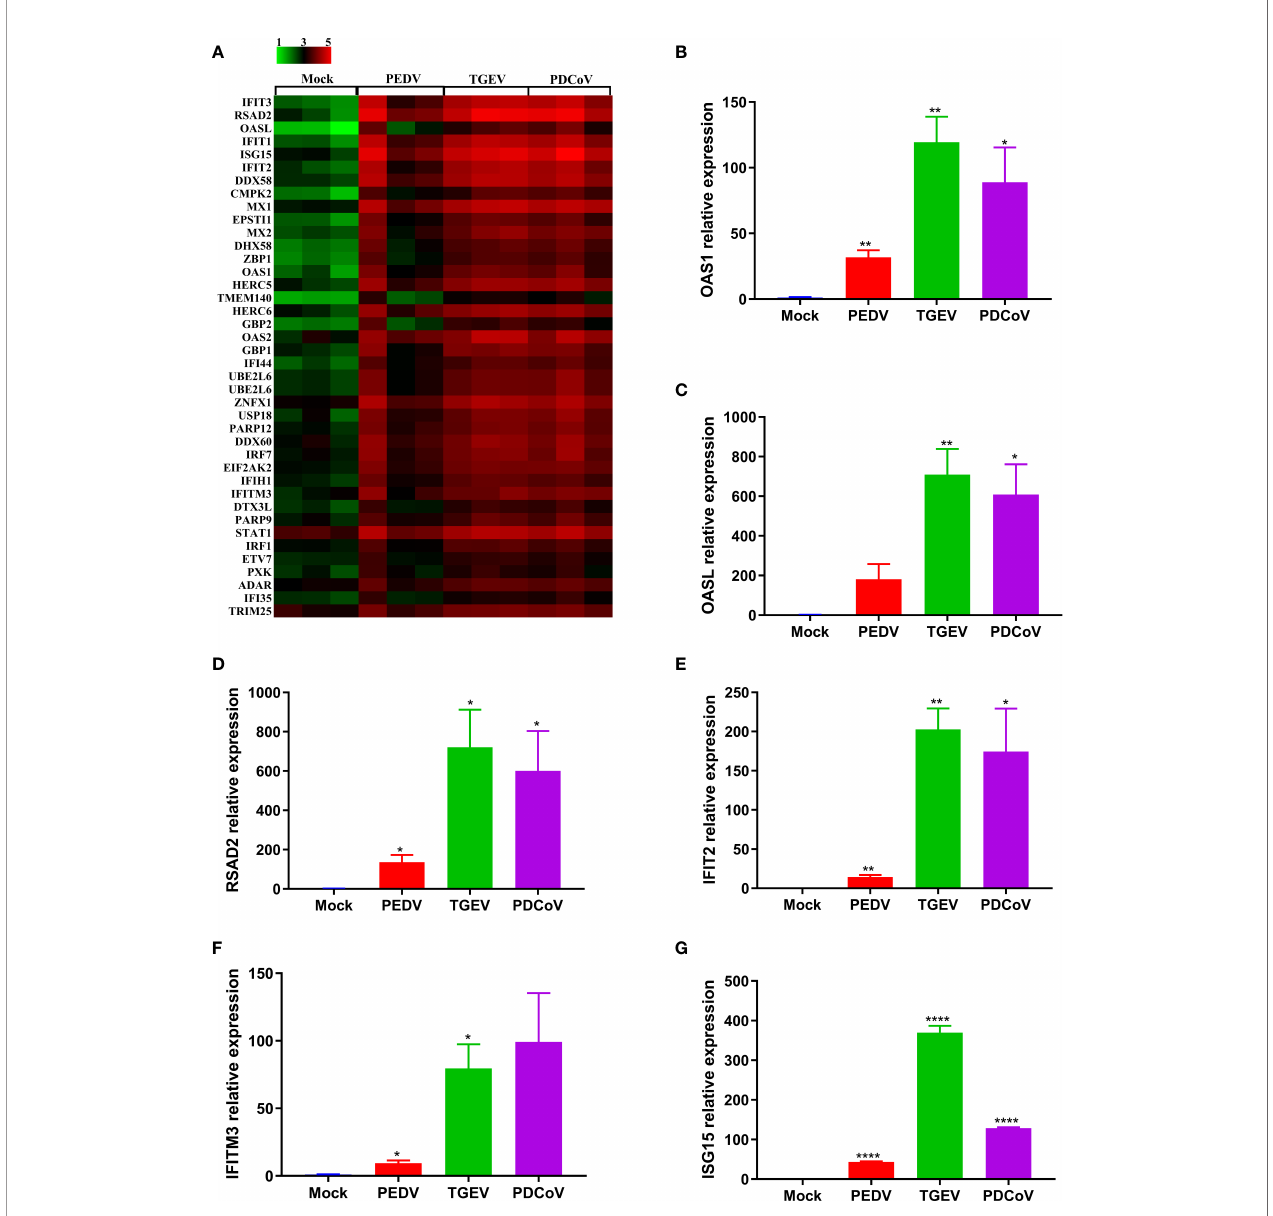
FIGURE 6 | PEDV infection elicits a poorer ISG response in enteroids than TGEV and PDCoV. (A) Heat map of robustly upregulated ISGs expression in enteroids following SECoVs infection. Jejunal enteroid monolayers infected with PEDV, TGEV, or PDCoV, and collected at 24 hpi for the analysis of ISGs expression pro fi les by RNA-Seq. Data are based on log(RPKM) values (n = 3). (B – G) Veri fi cation of ISGs expression in enteroids after SECoVs infection by RT-qPCR. The mRNA levels of OAS1 (B) , OASL (C) , RSAD2 (D) , IFIT2 (E) , IFIM3 (F) , and ISG15 (G) in jejunal enteroids following PEDV, TGEV, and PDCoV were measured by RT-qPCR. The results are presented as the means ± SEMs (n = 3). The differences between groups were compared using the Student ’ s t test. Error bars denote the deviations, and the p values are expressed as follows: * p < 0.05, ** p < 0.01, and **** p <